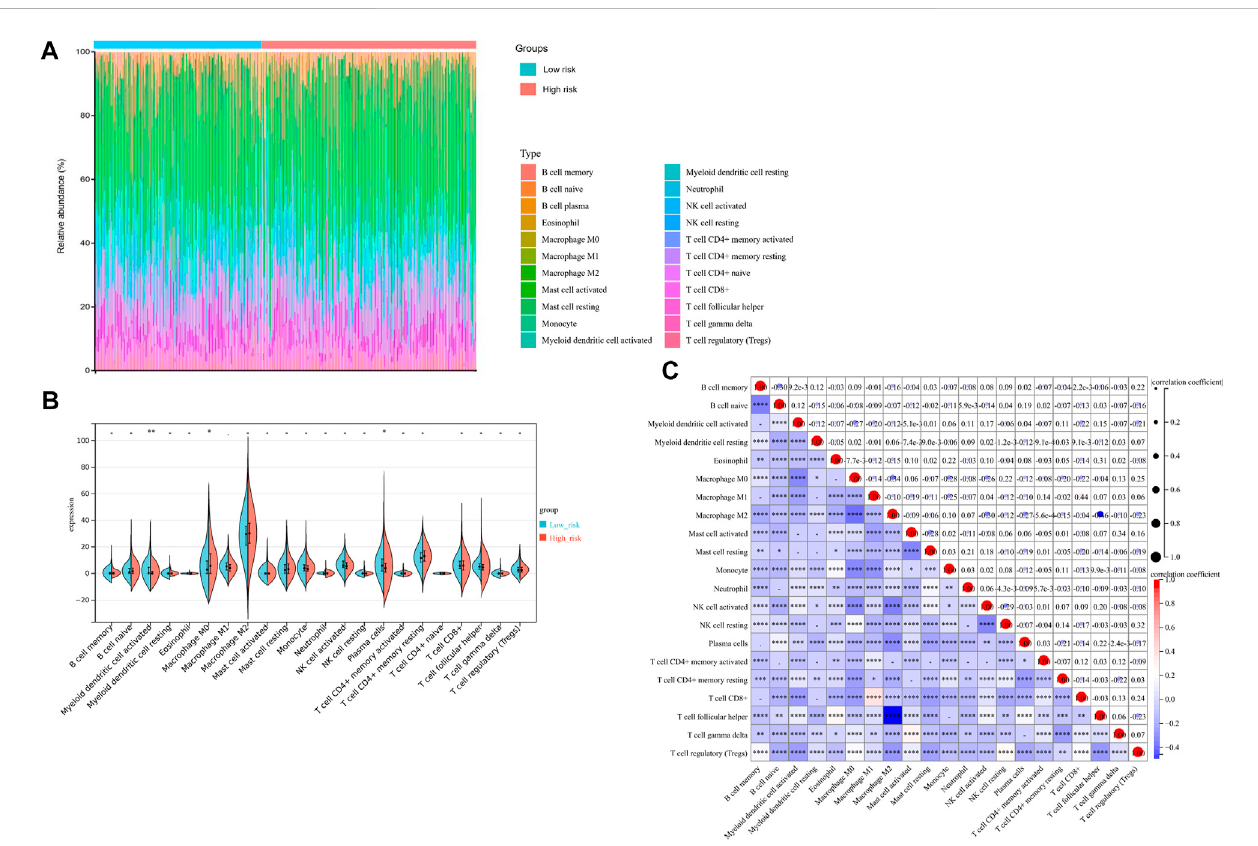
FIGURE 8 Immunity Analysis for the 3-gene Signature Risk Score and Tumor Immune Microenvironment. (A) The Boxplot diagram showed the composition of the 22 immune cells in fi ltrating in patients from low-risk and high-risk groups, based on the CIBERSORT analysis. (B) The Violin plot showed the difference of 22 immune cells in fi ltration correlationsbetweentwogroups strati fi edbythe3-gene Signature. (C) The correlation matrix for theproportion ofimmune cells in OV patients. * p -value < .05; ** p -value < .01; *** p -value < .001; **** p -value <